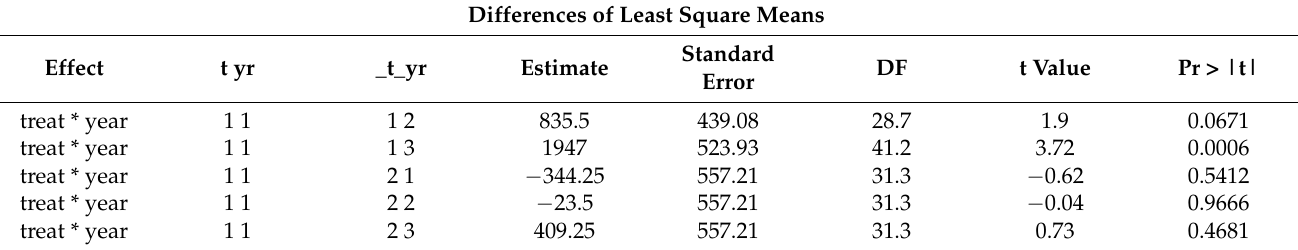
Table 4. Output 3: Partial output of the statistical analysis for the corn study with year treated as a repeated